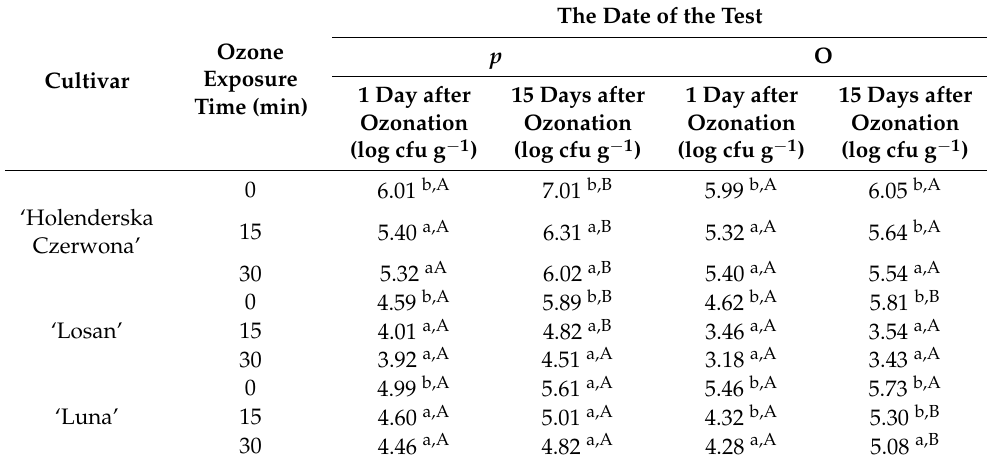
Table 5. Microbial load of yeasts and moulds in red currant fruit during storage. The Date of the Test Ozone p O Exposure Cultivar 15 Days after 1 Day after 15 Days after 1 Day after Time (min) Ozonation Ozonation Ozonation Ozonation (log cfu g − 1 ) (log cfu g − 1 ) (log cfu g − 1 ) (log cfu g − 1 ) 0 ‘Holenderska